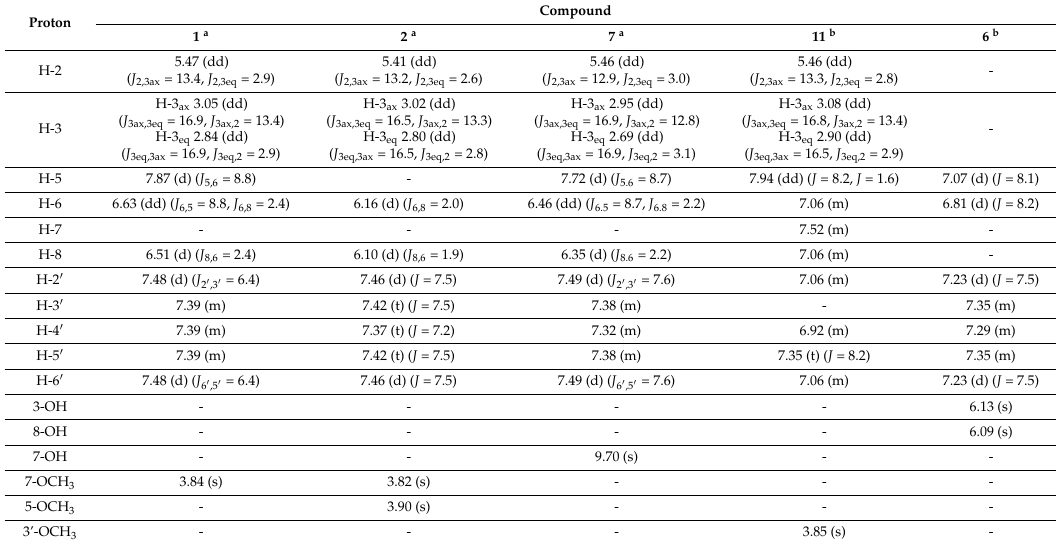
Table 1. 1 H-NMR chemical shifts ( δ ) of flavanones ( 1 , 2 , 7 , 11 ) and flavone ( 6 ) (Supplementary